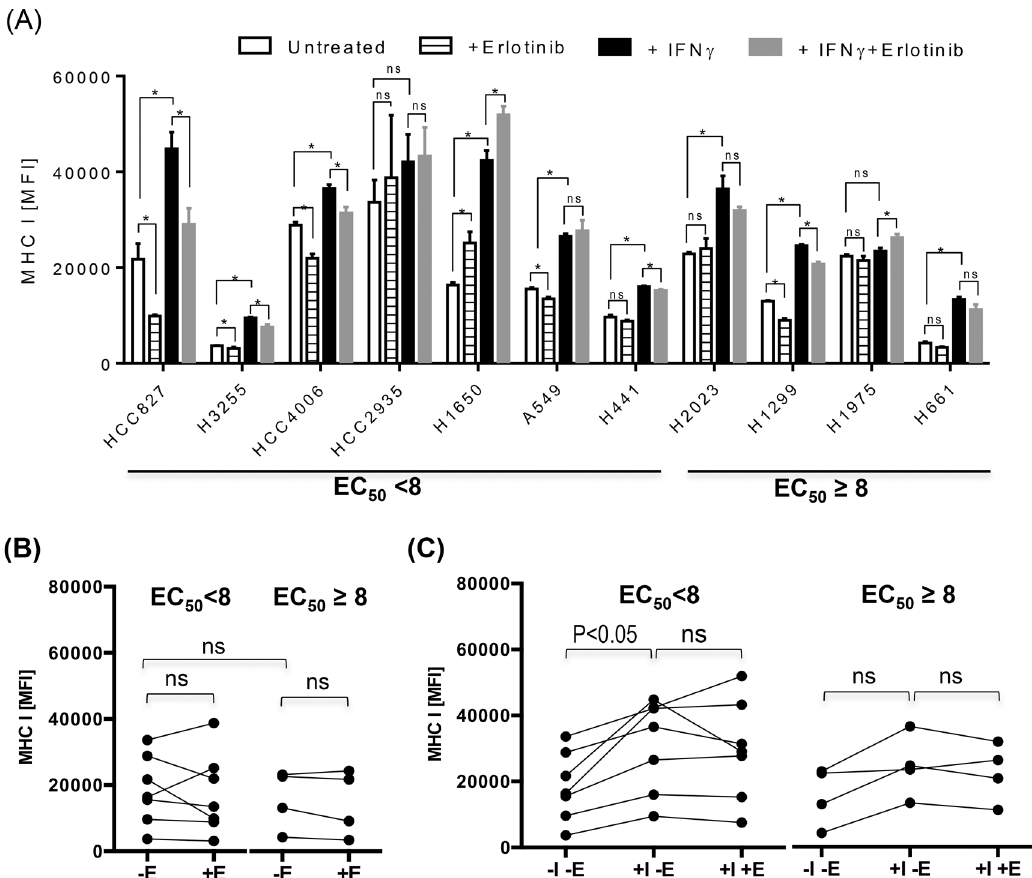
Fig 2. Differential effects on MHC-I in lung cancer cell lines by IFN γ and EGFR inhibitors. Various lung cancer cell lines were treated with IFN γ at a concentration of 1000 pg/ml in the presence or absence of erlotinib at concentration of 10 μ M for 24 hours, and assessed for surface expression of MHC-I. (A) The average mean fluorescence intensities (MFIs) ± standard deviation (SD) of MHC-I staining were represented as bar graphs.(B and C) For further statistical analysis, lung cancer cell lines were divided into two groups according to the half maximum effective concentration, EC 50 (EC 50 < 8 vs EC 50 (cid:2) 8) of erlotinib, and average MFI of MHC I for individual cell line was represented as a single dot for further statistical analysis to assess the impact of treatment with IFN γ and/or erlotinib on MHC I expression within group of lung cancer cell lines sensitive to erlotinib (EC 50 < 8) or resistant to erlotinib (EC 50 (cid:2) 8) There was a trend toward higher expression of MHC-I in untreated lung cancer cell lines sensitive to erlotinib (BB), and the treatment with IFN γ further up- regulated the expression of MHC-I more often on lung cancer cell lines sensitive to erlotinib compared to lung cancer cell line resistant to erlotinib (C). The addition of erlotinib to untreated or IFN γ treated lung cancer cell lines did not significantly altered the expression of MHC-I in most cell lines regardless of sensitivity to erlotinib (B and C). Abbreviations used in this experiment are as follow, E: erlotinib, I: IFN γ . The experiment shown here was performed in triplicates, and a representative of three independent experiments. P-value less than 0.05 was determined as statistically significance. “ NS ” represent “ statistically non-significant ”